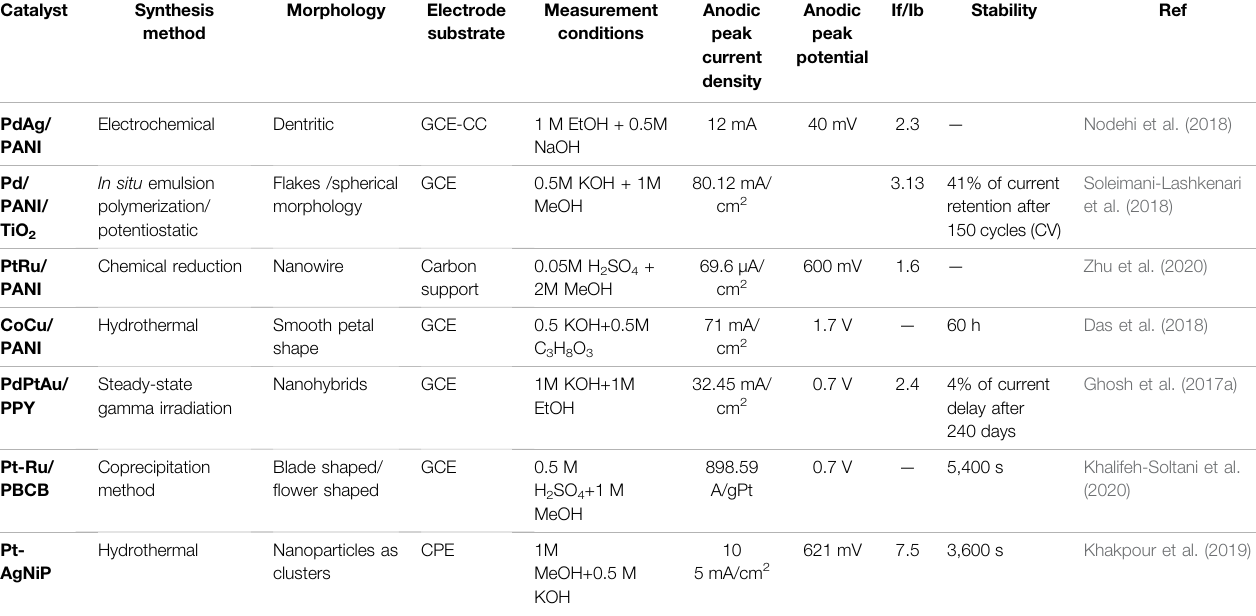
TABLE 3 | Electrochemical properties and electrocatalytic performances of bi and trimetallic-based conducting polymers catalyst applied for alcohol